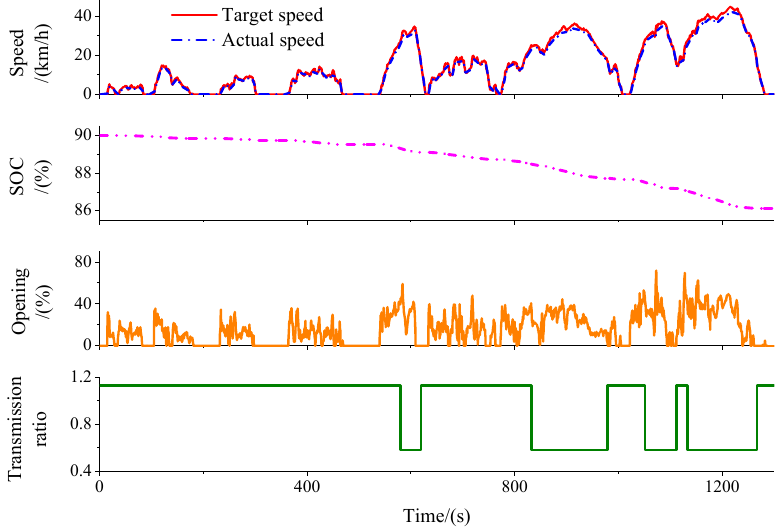
Figure 26. The simulation results of the energy consumption of the comprehensive shift rule. It can be seen in Figure 27 that the whole cycle lasts for 1300 s. In terms of the energy consumption evaluation index, the simulation results of the comprehensive shift rule are consistent with the optimal economic shift rule. All of them shift actively. Besides, the energy consumption of the machine is reduced. The SOC of the optimal power shift rule decreases from 90.00% to 86.06%, and that of the comprehensive shift rule decreases from 90.00% to 86.13%, which is 0.07% less than that of the optimal power shift rule, about 0.20 kWh, accounting for 1.78% of the SOC consumed by the optimal power shift rule. The SOC difference is mainly composed of five parts marked in Figure 27, accounting for 4.34%, 61.20%, 23.95%, 4.20%, and 6.30% of the total reduction, respectively. Combined with the opening pedal curve, it can be obtained that the first, fourth, and fifth parts are medium and high load areas, and that their SOC consumption accounts for only 14.85% of the total consumption, while the second and third parts are medium and low load areas, and their SOC consumption accounts for 85.15% of the total consumption.